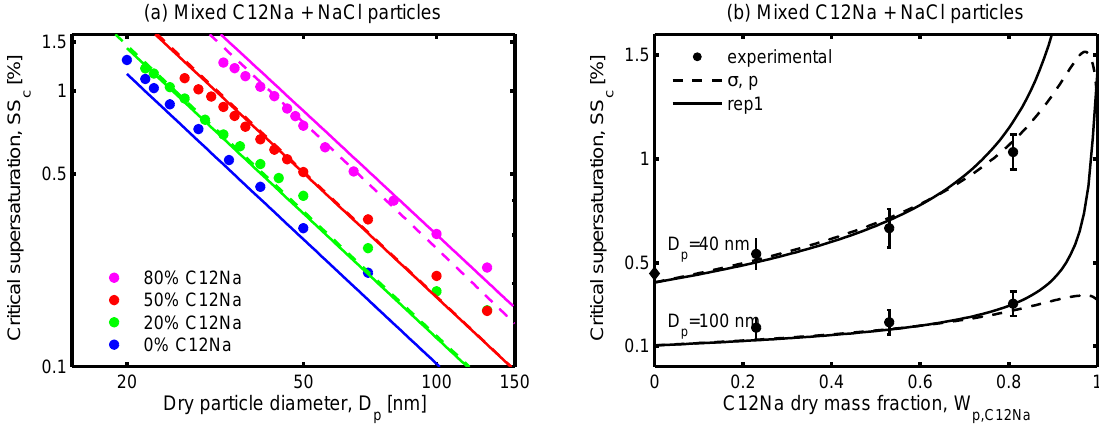
thermodynamic model ( (cid:27); p ), both adapted from Prisle et al. (2010), and solid lines are calculated with the simple organic representation